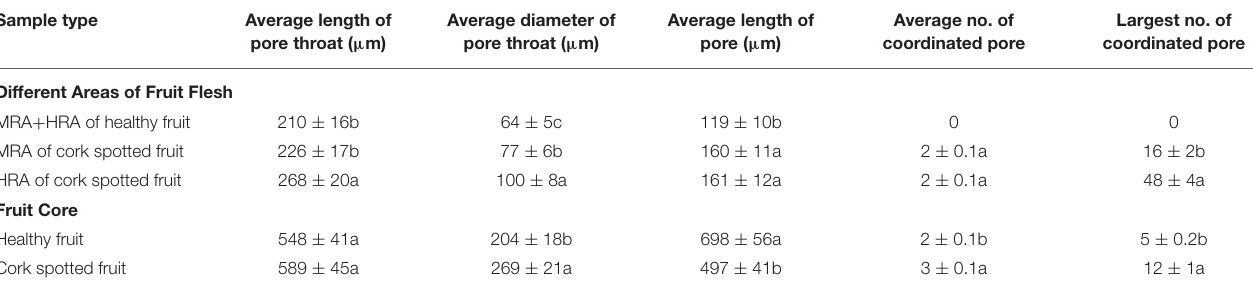
TABLE 4 | Analysis of the morphometric parameters in different areas of healthy and cork spotted fruit under the reconstructed 3D network model. Sample